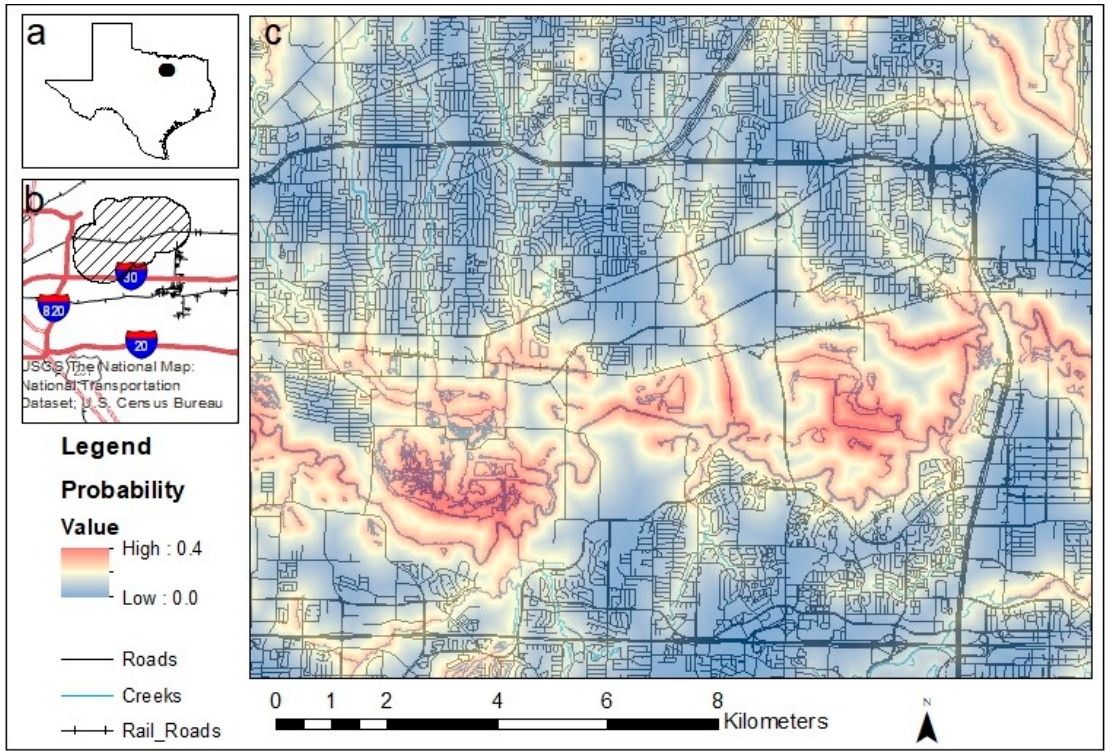
Figure 1. ( a ) Location of the Dallas–Fort Worth (DFW) metroplex, Texas, USA; ( b ) specific study site (hashed polygon) within the DFW metroplex; and ( c ) heat map from the resource selection function model created using data from GPS-collared bobcats in the study site. The Trinity River runs east–west through the south-end of the study area.